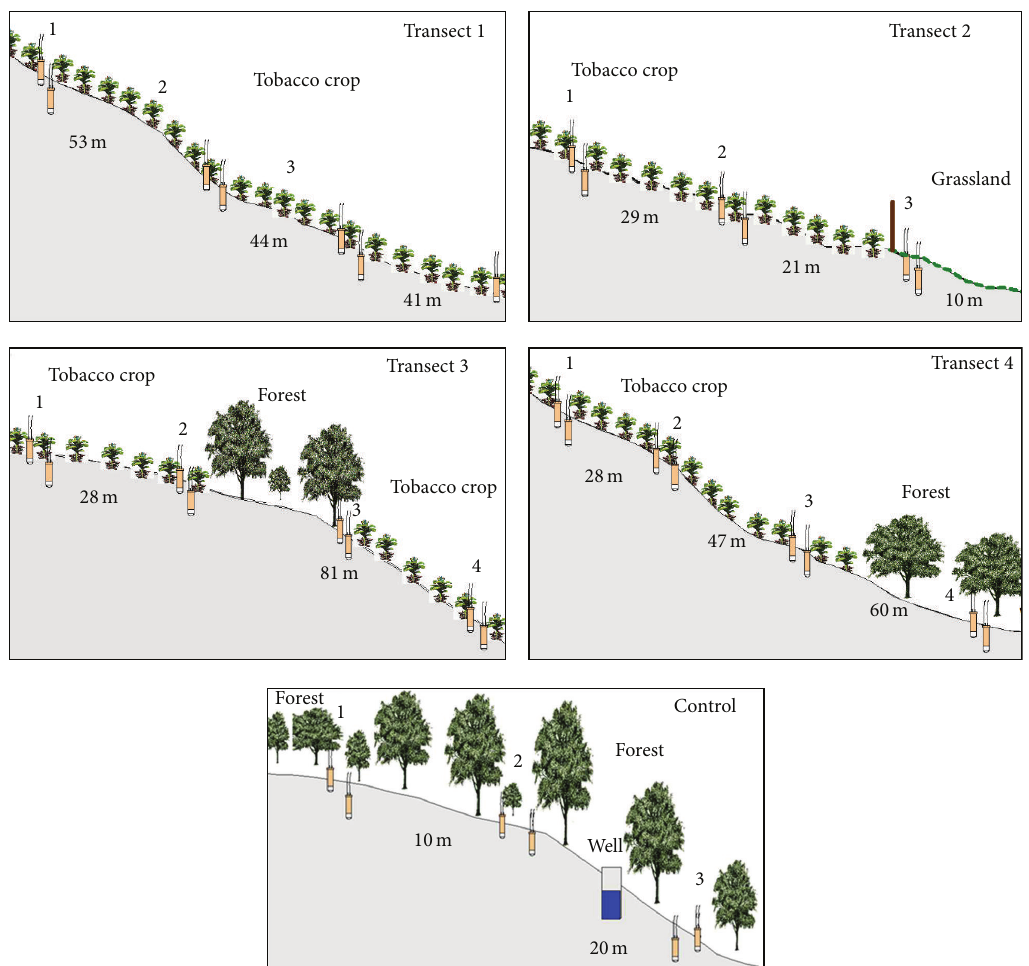
Figure 2: Distribution of collection points for transects with different soil uses. Points indicate lysimeters in transects along the landscape.